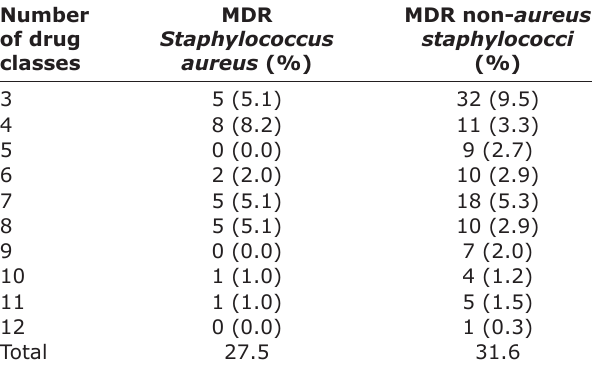
Table-3: Multidrug-resistant Staphylococcus aureus and non- aureus staphylococci spp. isolated from goat milk in Paraiba State, Northeast